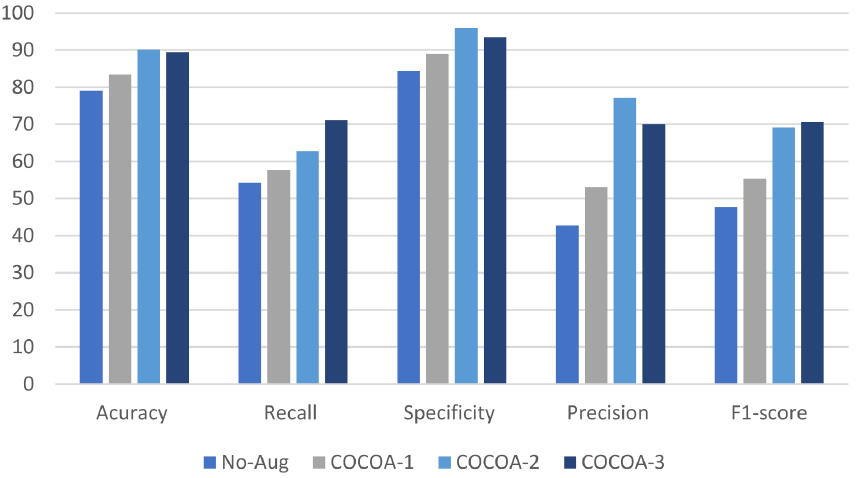
Figure 6. Comparison of performance metrics for Mel-spectrogram (Healthy vs. positive COVID-19).